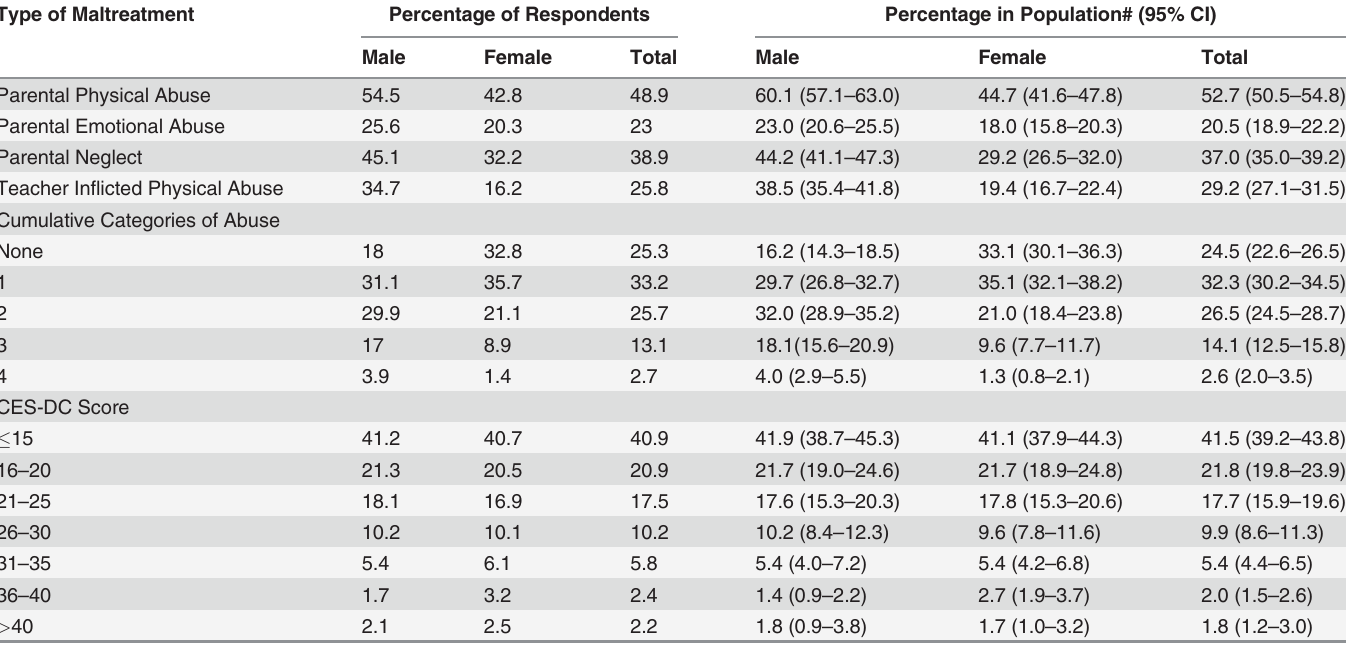
Table 1. Prevalence of speci fi c type of maltreatment, cumulative abuse and range of CES-DC score. Type of